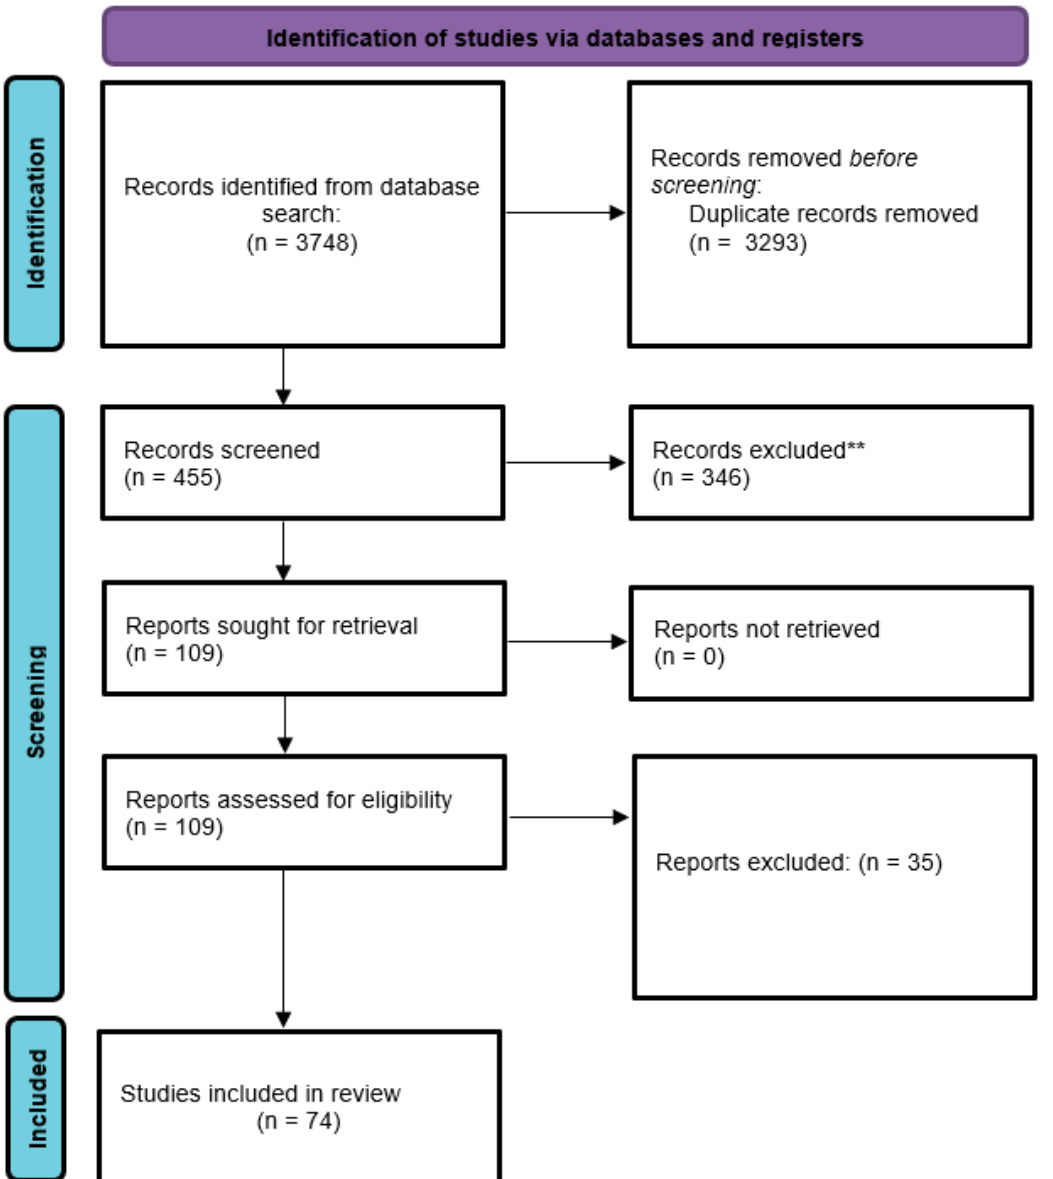
Figure 1. PRISMA flow diagram. From: Page MJ, McKenzie JE, Bossuyt PM, Boutron I, Hoffmann TC, Mulrow CD, et al. The PRISMA 2020 statement: an updated guideline for reporting systematic reviews. BMJ 2021; 372: n71. doi: 10.1136/bmj.n71. For more information, visit: http://www.prisma- statement.org/. Accessed on 28 January 2022.